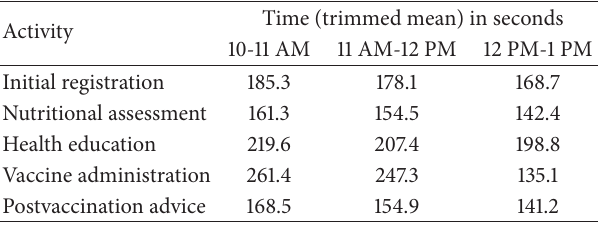
Table 4: Service delivery time (trimmed mean) in relation to time of